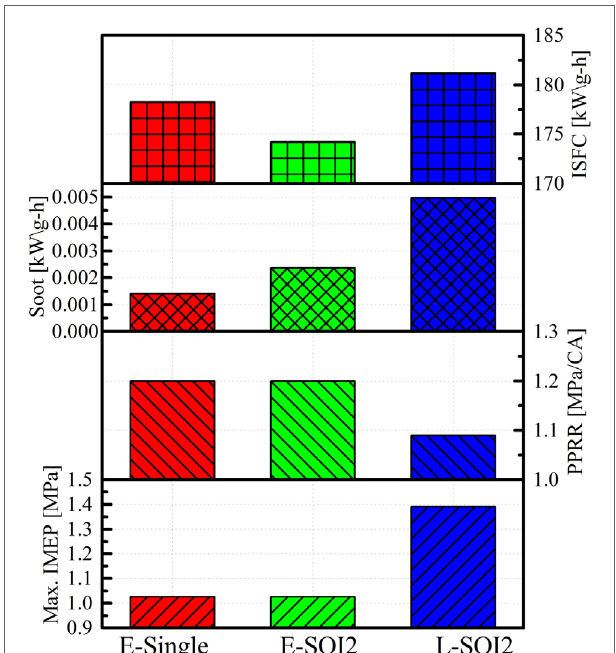
FiGURe 11 | The maximum achievable load with different injection strategies in HPCC combustion mode